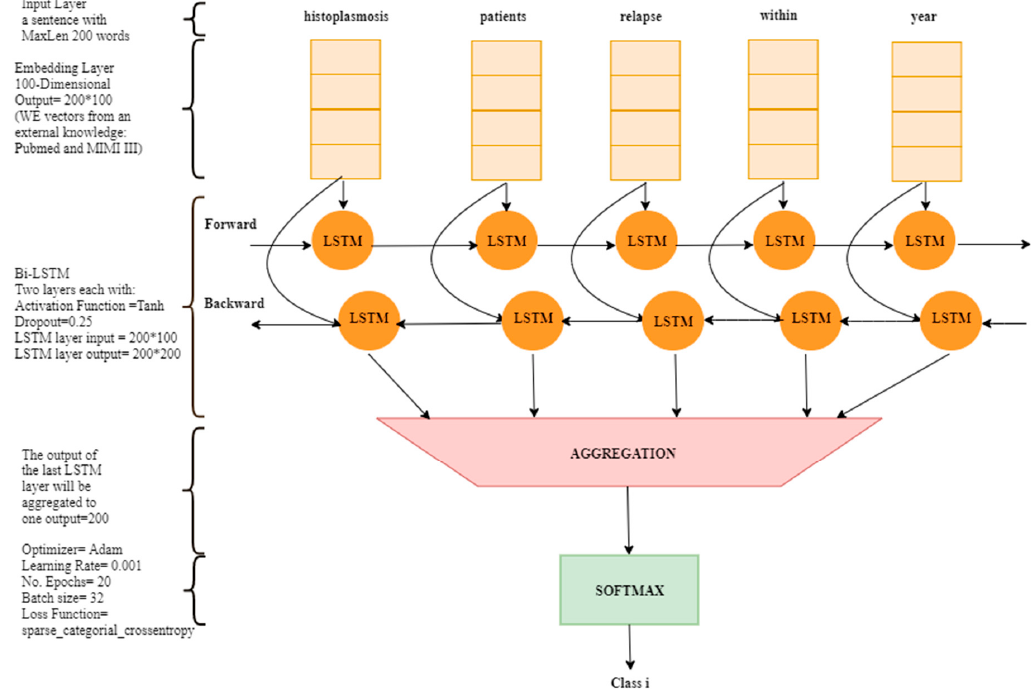
Figure 2. The architecture of our bidirectional long short-term memory (BLSTM) multiclass classification system. Bidirectional LSTM layers: we created one BLSTM layer which consists of the hyperparameters of Tanh for activation function and a dropout value of